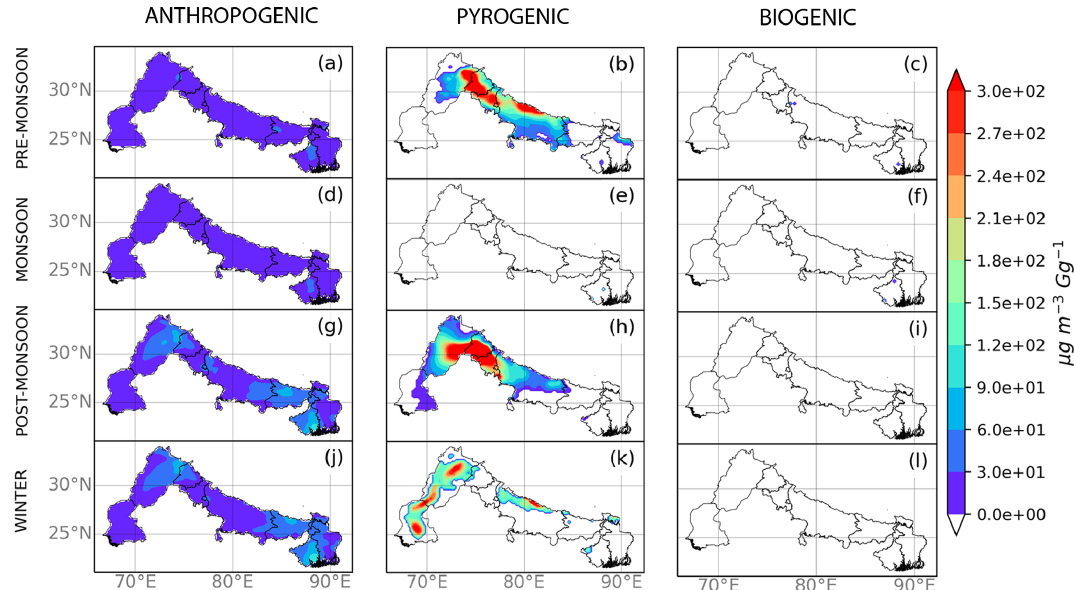
Figure A4. Seasonal sensitivity of POA to changes in (a, d, g, j) anthropogenic, (b, e, h, k) pyrogenic, and (c, f, i, l) biogenic emissions (µgm − 3 Gg − 1 ). The sensitivity calculation is described in the main text. Regions marked in white show where sensitivity corresponds to OA concentrations below the set threshold of 1µgm − 3 .